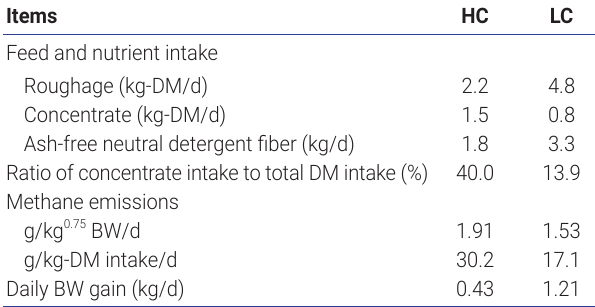
Table 1. Feed and nutrient intake, methane emissions, and daily body- weight gain of two Simmental crossbred beef cattle fed a high- or low-concentrate diet (Exp 1)